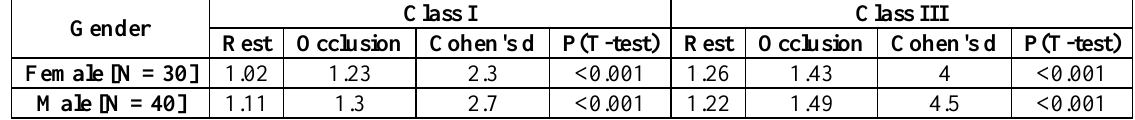
Class III Class I